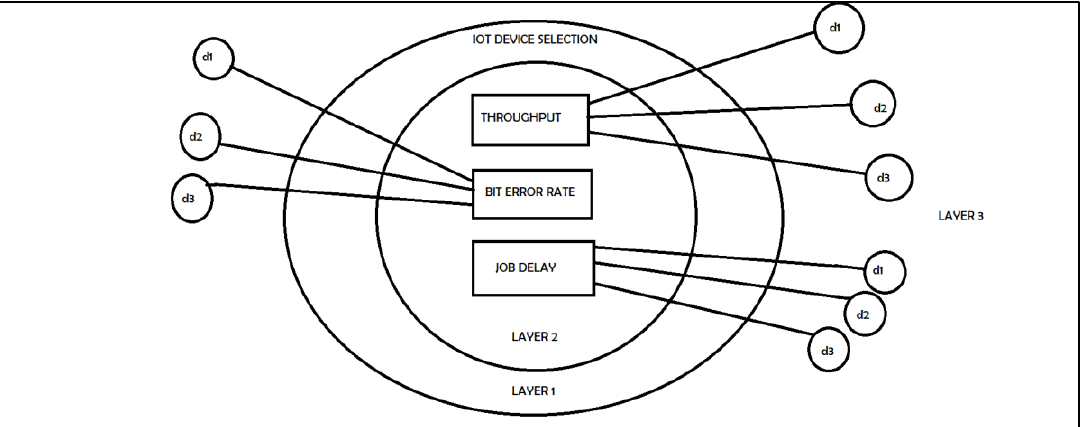
Figure 1. Resource allocation scheme over various